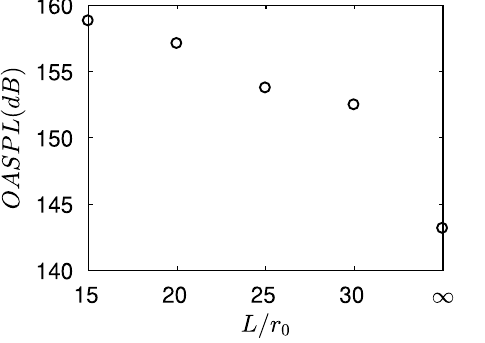
Figure 7. Overall sound pressure levels (OASPL) at z = 0 and r = 2 r 0 as a function of the nozzle-to-plate distance.